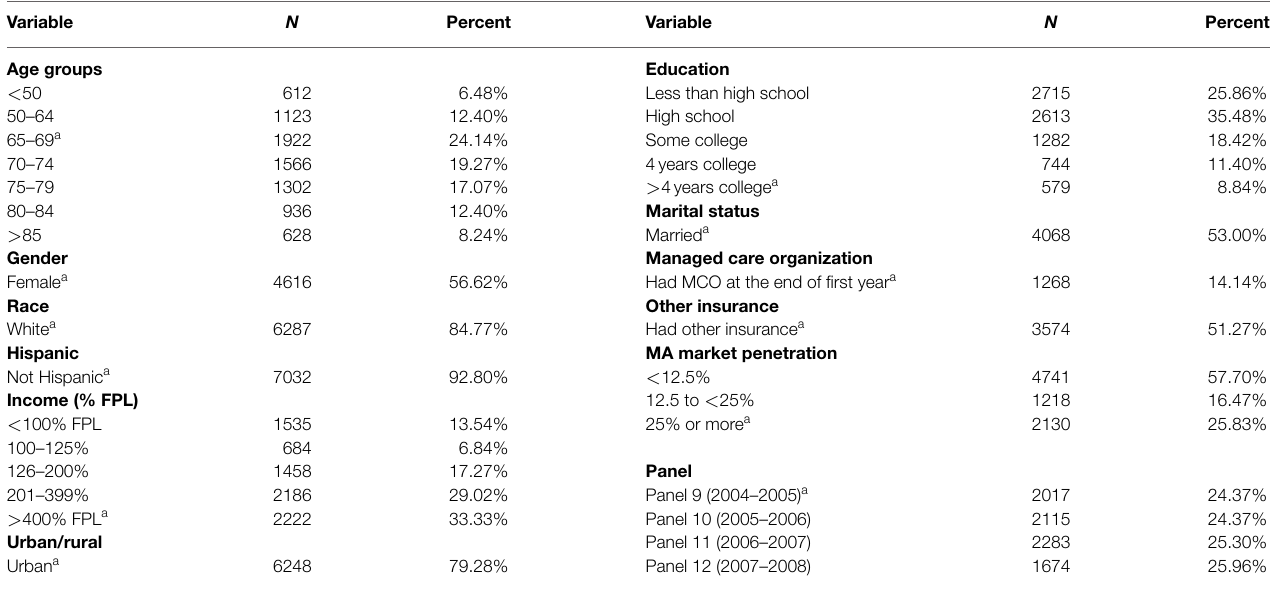
TABLE 1 | Descriptive statistics.